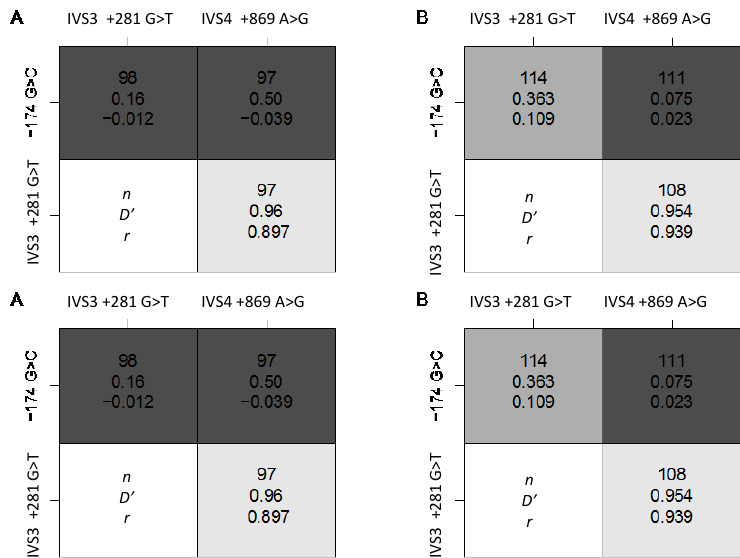
Figure 1. LD structure of IL-6 polymorphisms ( n , number of women; Dʼ , Lewontin’s D ; r , coefficient of correlation) for IL-6 polymorphisms of normal-weight and obese black and white women. LD plots showing ( A ): Normal Black; ( B ) Obese Black; ( C ) Normal White; ( D ) Obese White. Shading determined by value of Dʼ —light indicates high